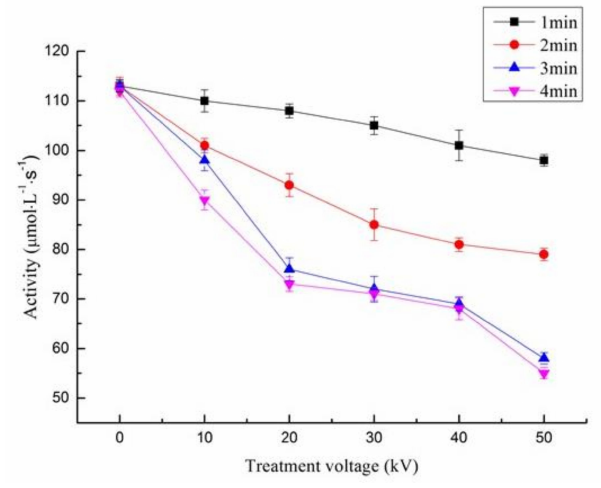
Figure 3. Impact of ACP treatment at a different time and voltages on the activity of trypsin (mean ± SD, n = 3). Control (0 min) refers to samples without ACP treatment.